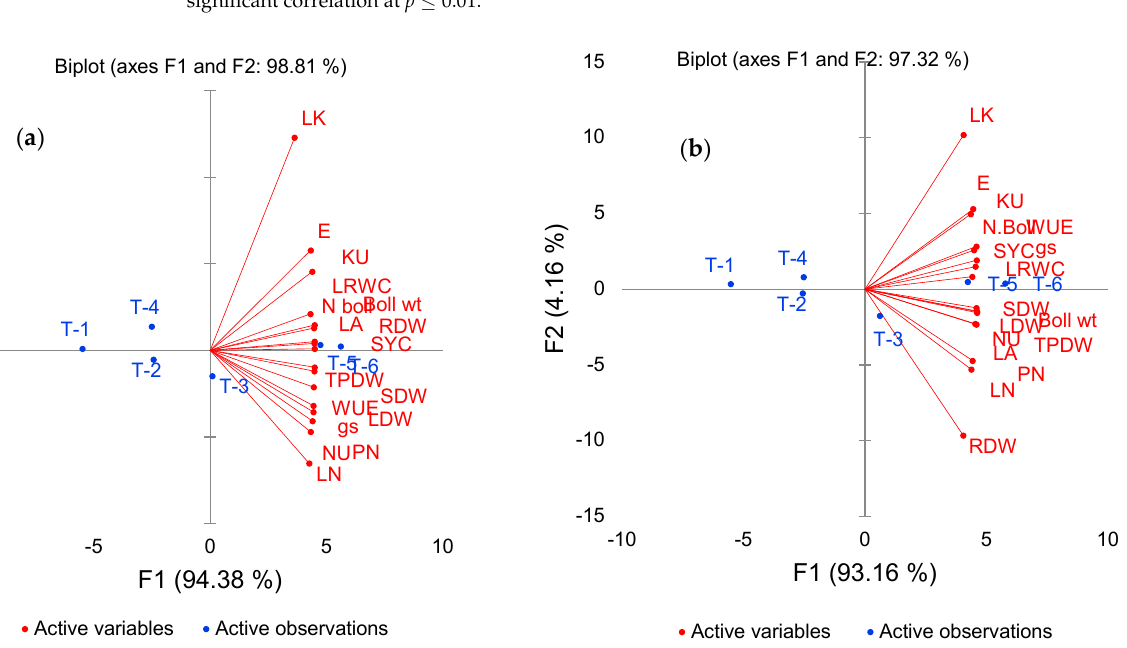
Figure 4. Performance of ( a ) HKE (CIM-554; high-K-efficiency cultivar) and ( b ) LKE (FH-901; low-K-efficiency cultivar) cotton cultivars, as affected by N:K levels under varied irrigation levels.